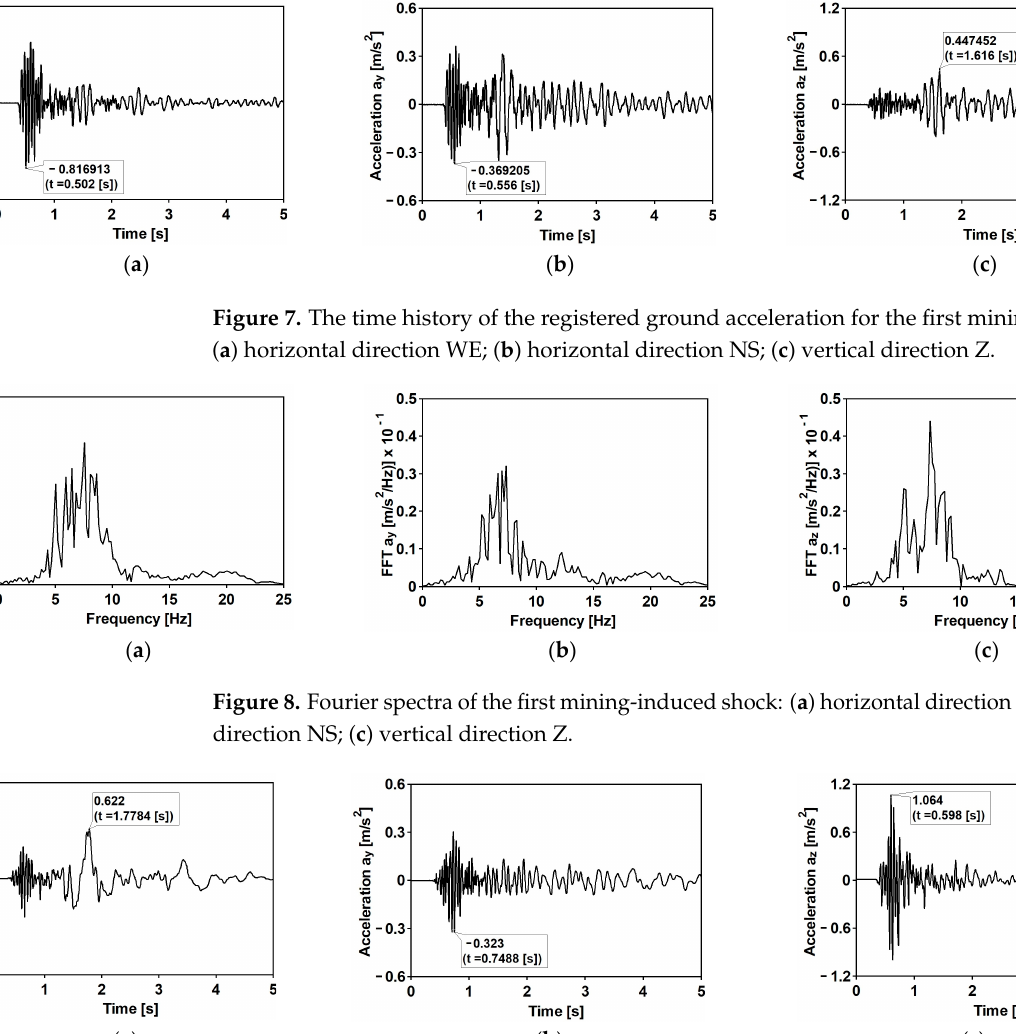
Figure 9. The time history of the registered ground acceleration for the second mining-induced shock: ( a ) horizontal direction WE; ( b ) horizontal direction NS; ( c ) vertical direction Z. ( a ) ( b ) ( c ) Figure 10. Fourier spectra of the second mining-induced shock: ( a ) horizontal direction WE; ( b ) hor- izontal direction NS; ( c ) vertical direction Z. 4. Adopted Finite Element Model for Numerical Analyses The finite element (FE) elastic model of the footbridge (Figure 11) was implemented in ABAQUS/Standard [36]. The 8-node and 3-node brick finite elements were used to model concrete elements and transverse steel beams, and the steel beams of the girders were modeled by 3-node shell elements. The total number of elements was about 316,000, and the element dimensions were determined based on the convergence analysis, with the first natural frequency value serving as the convergence criterion. Kinematic coupling constraints are given between the bottom of the girders and the top of the pillars based on the different bearing types applied in the structure. Due to efficiency reasons, non-